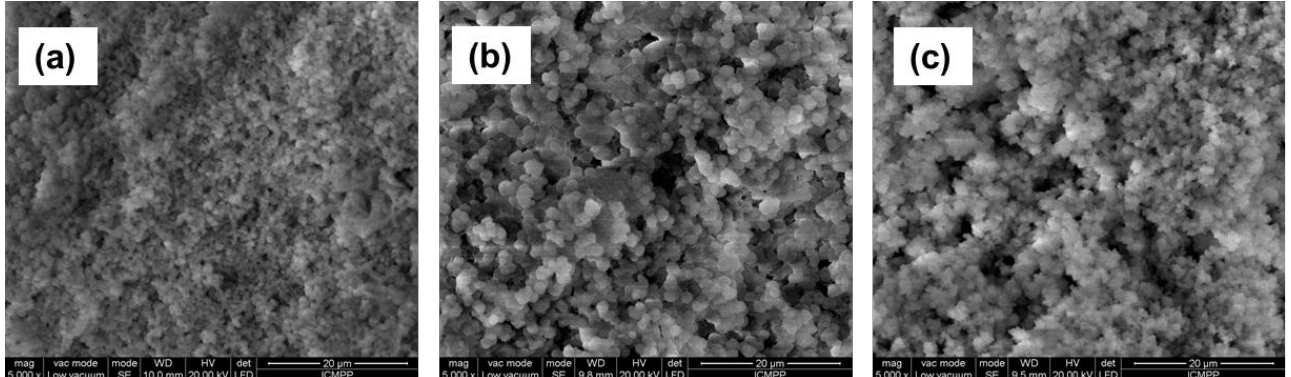
Figure 8. The influence of the solvent of P4VPB-2 on the surface morphology of PHEMA/P4VPB-2: ( a ) sodium bicarbonate, 0.25N; ( b ) CH 3 OH:sodium bicarbonate (40:60, v / v ); ( c ) C 2 H 5 OH:sodium bicarbonate (40:60, v / v ) (HEMA:TEGDMA = 1:50, mol/mol HEMA:P4VPB-2 = 1:0.5 g/g). The presence of P4VP, P4VPB-1 and P4VPB-2 in the structure of the semi-IPNs was